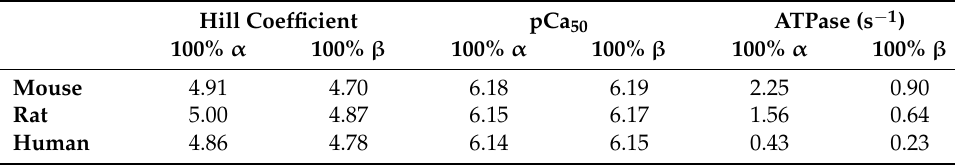
Table 4. Force-pCa relations for α - and β -myosin isoforms across the species. Hill